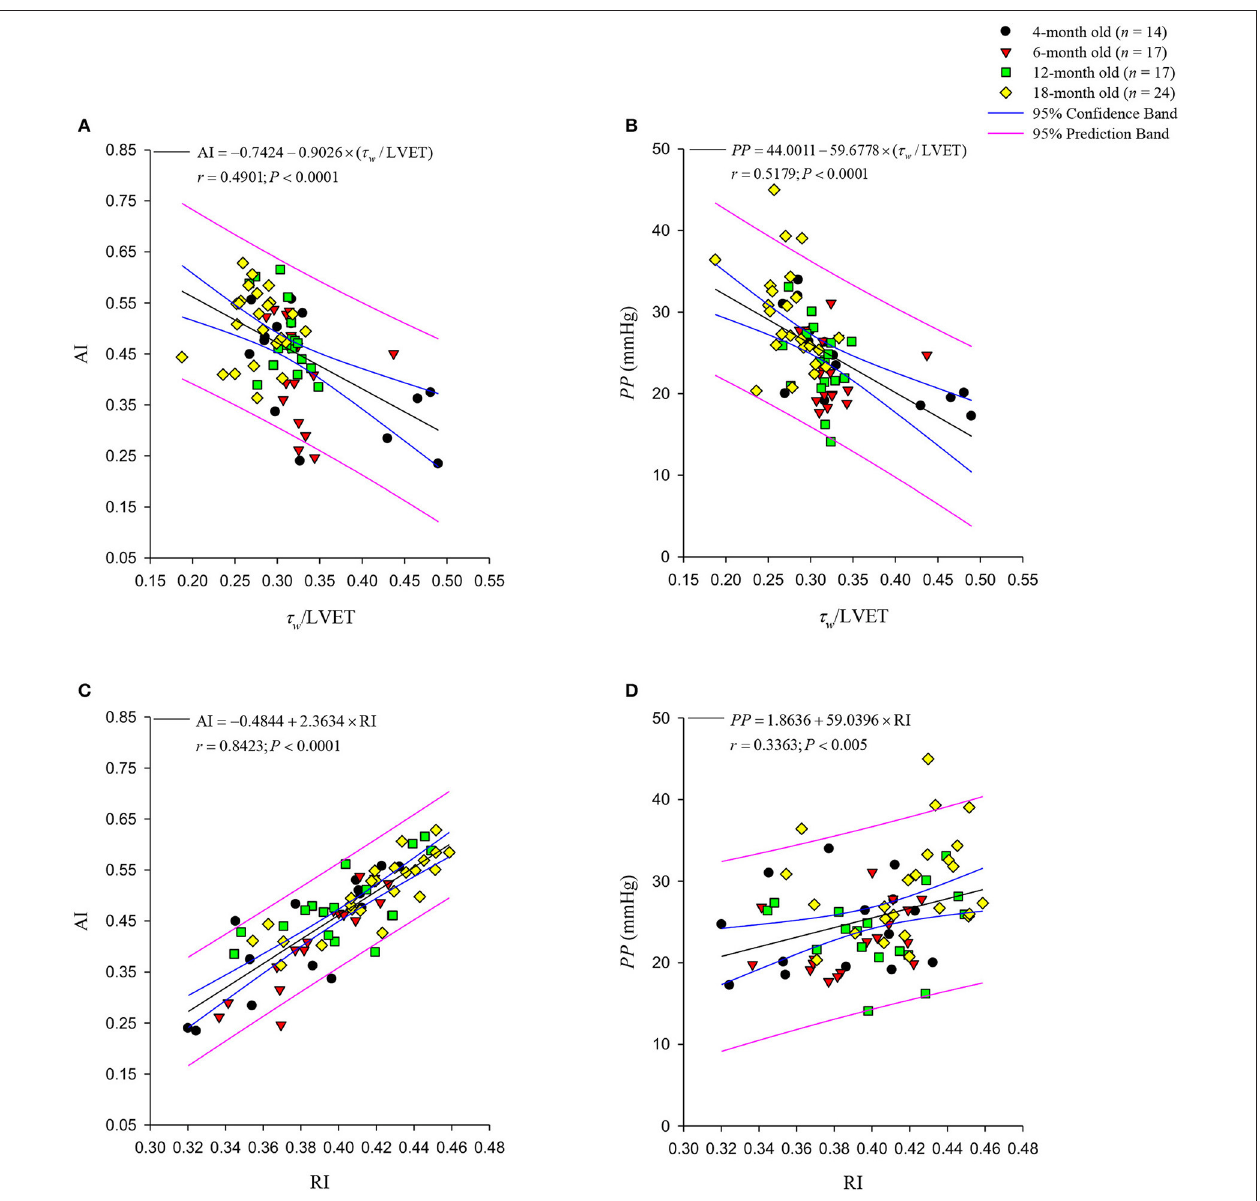
FIGURE 7 | Relationships between the augmentation index (AI) and the ratio of wave transit time ( τ w ) to left ventricular ejection time (LVET) (A) and wave reflection index RI (C) . The aortic AI was significantly inversely related to the τ w /LVET ratio. By contrast, the RI and the aortic AI were directly related. In (B) , the pulse pressure ( PP ) shows a negative linear correlation with the τ w /LVET ratio. The positive regression line of PP with RI is depicted in (D) . The aortic AI had a closer correlation with the RI than the PP did.